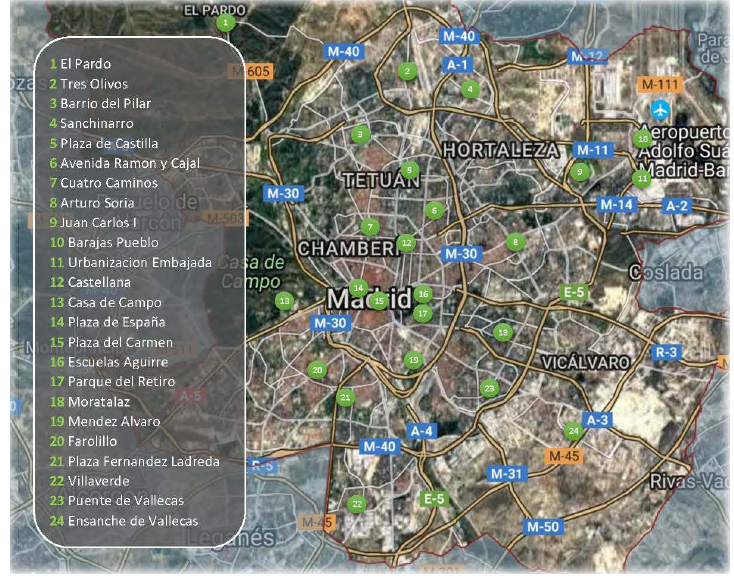
Figure 2. Air Quality Monitoring Network of